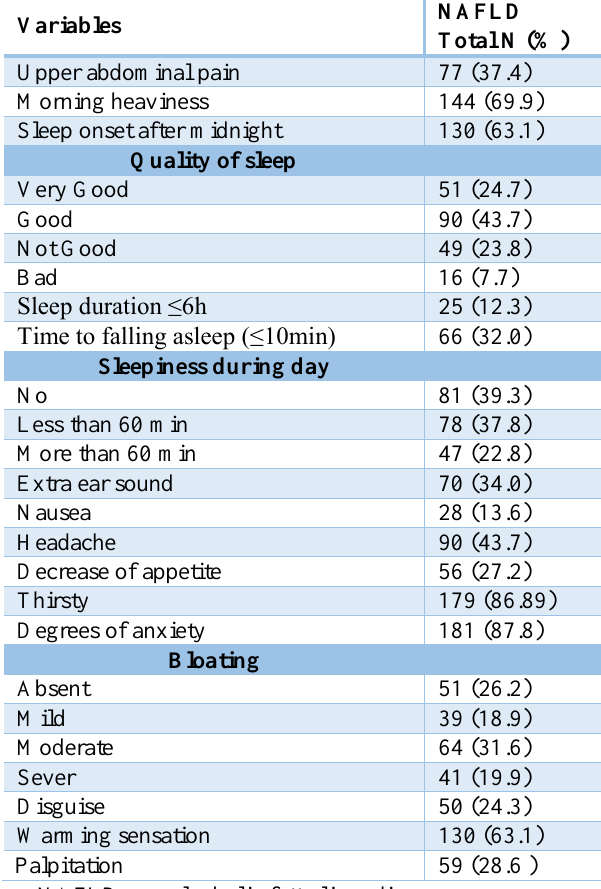
Table 2. Clinical Manifestations of Patients With